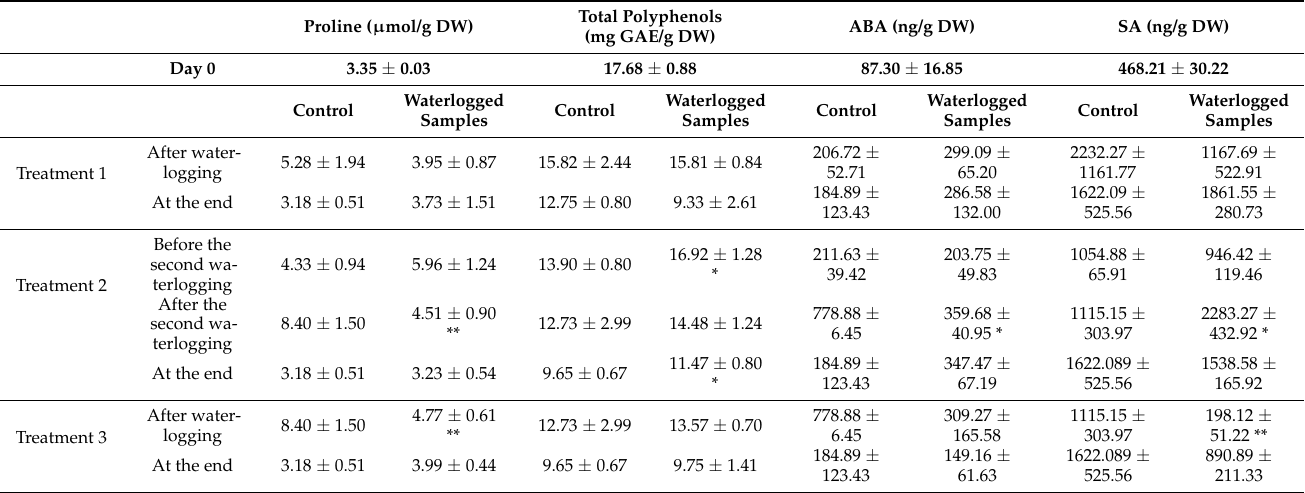
Table 5. Changes in molecular stress parameters under waterlogging.